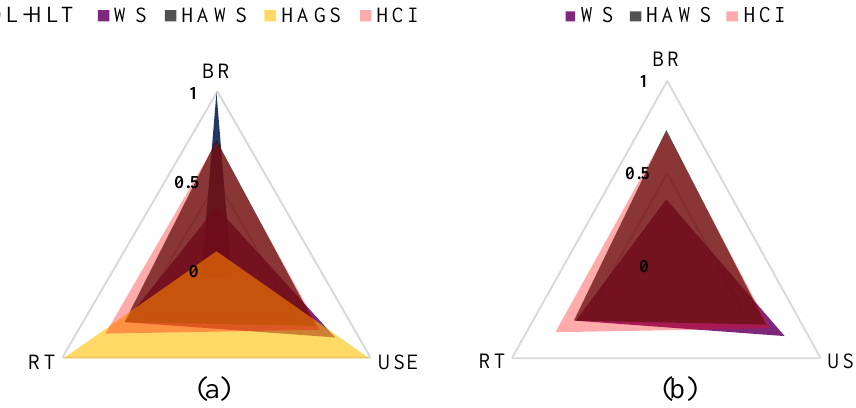
Figure 19. Radar chart of the RADARSAT-2 data set. ( a ) Radar chart including POL-HLT, WS, HAWS, HAGS and the proposed HCI. ( b ) Radar chart including WS, HAWS and the proposed